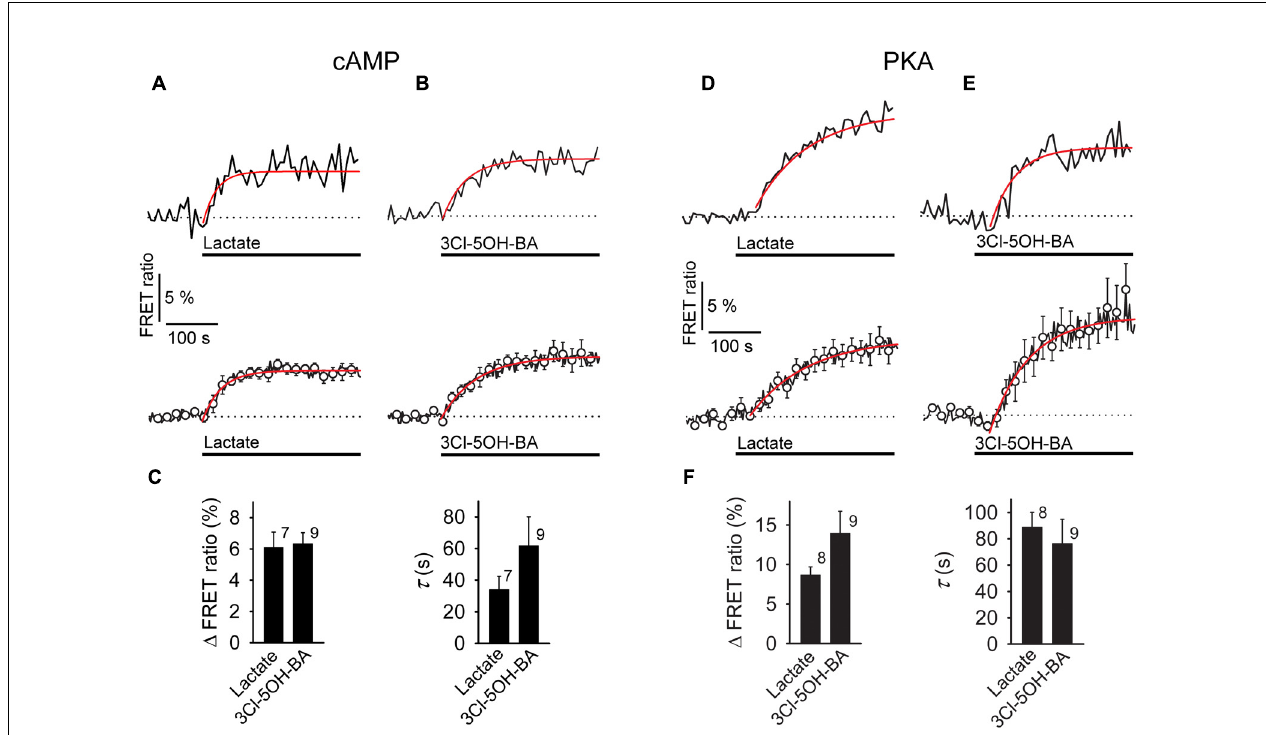
FIGURE 1 | Application of L -lactate and 3Cl-5OH-BA increases [cAMP] i and the intracellular PKA activity in rat astrocytes. (A,B) Representative (above) and mean time-course (below) of the Epac1-camps FRET ratio signal upon the addition of (A) L -lactate (20 mM) and (B) 3Cl-5OH-BA (0.5 mM), a selective agonist of the GPR81 receptor. Data are expressed as percentages of the inverse FRET ratio signal (CFP/YFP) relative to the baseline values. Single exponential rise functions were fitted to the curves: ( A , above) FRET ratio = [0.98 ± 0.01] + [0.06 ± 0.01] × (1 – exp(– t /[25.00 ± 5.63 s])), ( A , below) FRET ratio = [1.00 ± 0.00] + [0.05 ± 0.00] × (1 – exp(– t /[ 35.71 ± 2.55 s])), and ( B , above) FRET ratio = [0.94 ± 0.00] + [0.06 ± 0.01] × (1 – exp(– t /[41.49 ± 5.85 s])), ( B , below) FRET ratio = [1.00 ± 0.00] + [0.07 ± 0.00] × (1 – exp( t /[66.67 ± 4.42 s])). Note that the addition of L -lactate and 3Cl-5OH-BA increased the FRET ratios, indicating increases in [cAMP] i . Each data point represents the mean ± s.e.m. (C) Mean changes in the FRET ratio ( (cid:49) FRET ratio) and mean time-constants ( τ ) upon L -lactate and 3Cl-5OH-BA stimulation. Changes in FRET ratio are expressed as percentages relative to the initial values. The numbers by the bars depict the number of cells analyzed. Data are shown as the means ± s.e.m. (D,E) Representative (above) and mean time-course (below) of the AKAR2 FRET ratio signal upon addition of (D) L -lactate (20 mM) and (E) 3Cl-5OH-BA (0.5 mM). Data are expressed as percentages of the FRET ratio signals (YFP/CFP) relative to the baseline ratio values. Single exponential rise functions were fitted to the curves: ( A , above) FRET ratio = [1.01 ± 0.00] + [0.10 ± 0.00] × (1 – exp(– t /[90.91 ± 8.26 s])), ( A , below) FRET ratio = [1.00 ± 0.00] + [0.08 ± 0.00] × (1 – exp(– t /[111.11 ± 9.91 s])), and ( B , above) FRET ratio = [0.97 ± 0.01] + [0.10 ± 0.01] × (1 – exp(– t /[47.62 ± 4.54 s])), ( B , below) FRET ratio = [0.98 ± 0.00] + [0.12 ± 0.00] × (1 – exp(– t /[71.43 ± 5.10 s])). Note that the addition of L -lactate and 3Cl-5OH-BA increased the FRET ratios, indicating increased PKA activity. Each data point represents the mean ± s.e.m. (F) Mean changes in the FRET ratio ( (cid:49) FRET ratio) and mean time-constants ( τ ) upon L -lactate and 3Cl-5OH-BA stimulation. The numbers by the bars depict the number of cells analyzed. Data shown are in the format of the mean ± s.e.m. Data for every set of experiment was acquired from at least two different